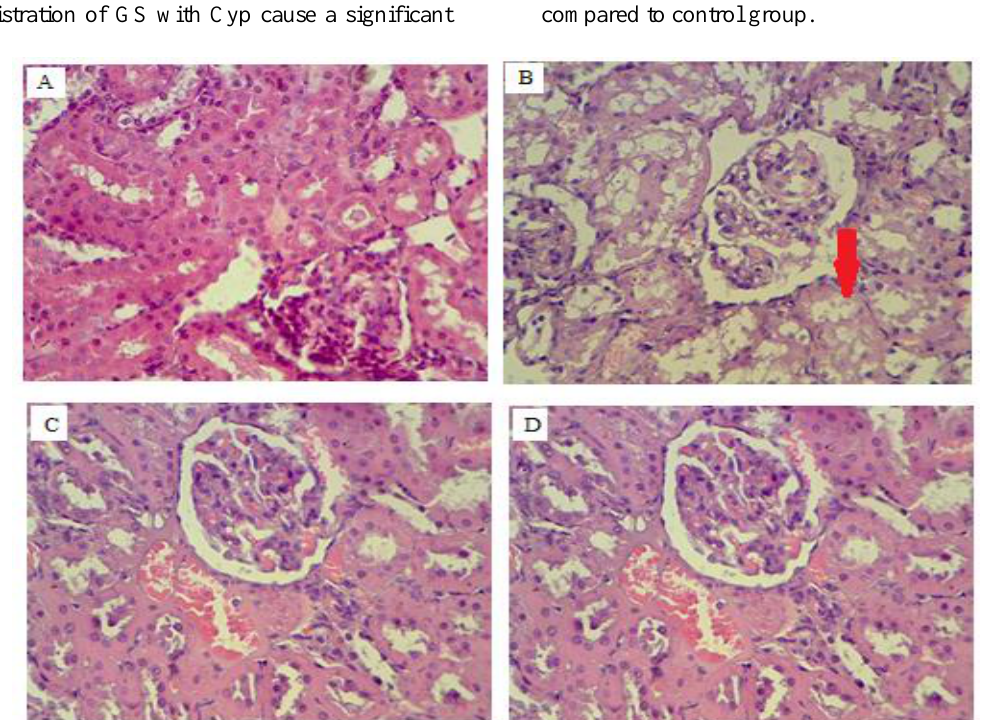
Figure 1C, the Cyclophosphamide + guggulsterone treatment showed narrow degenerative area